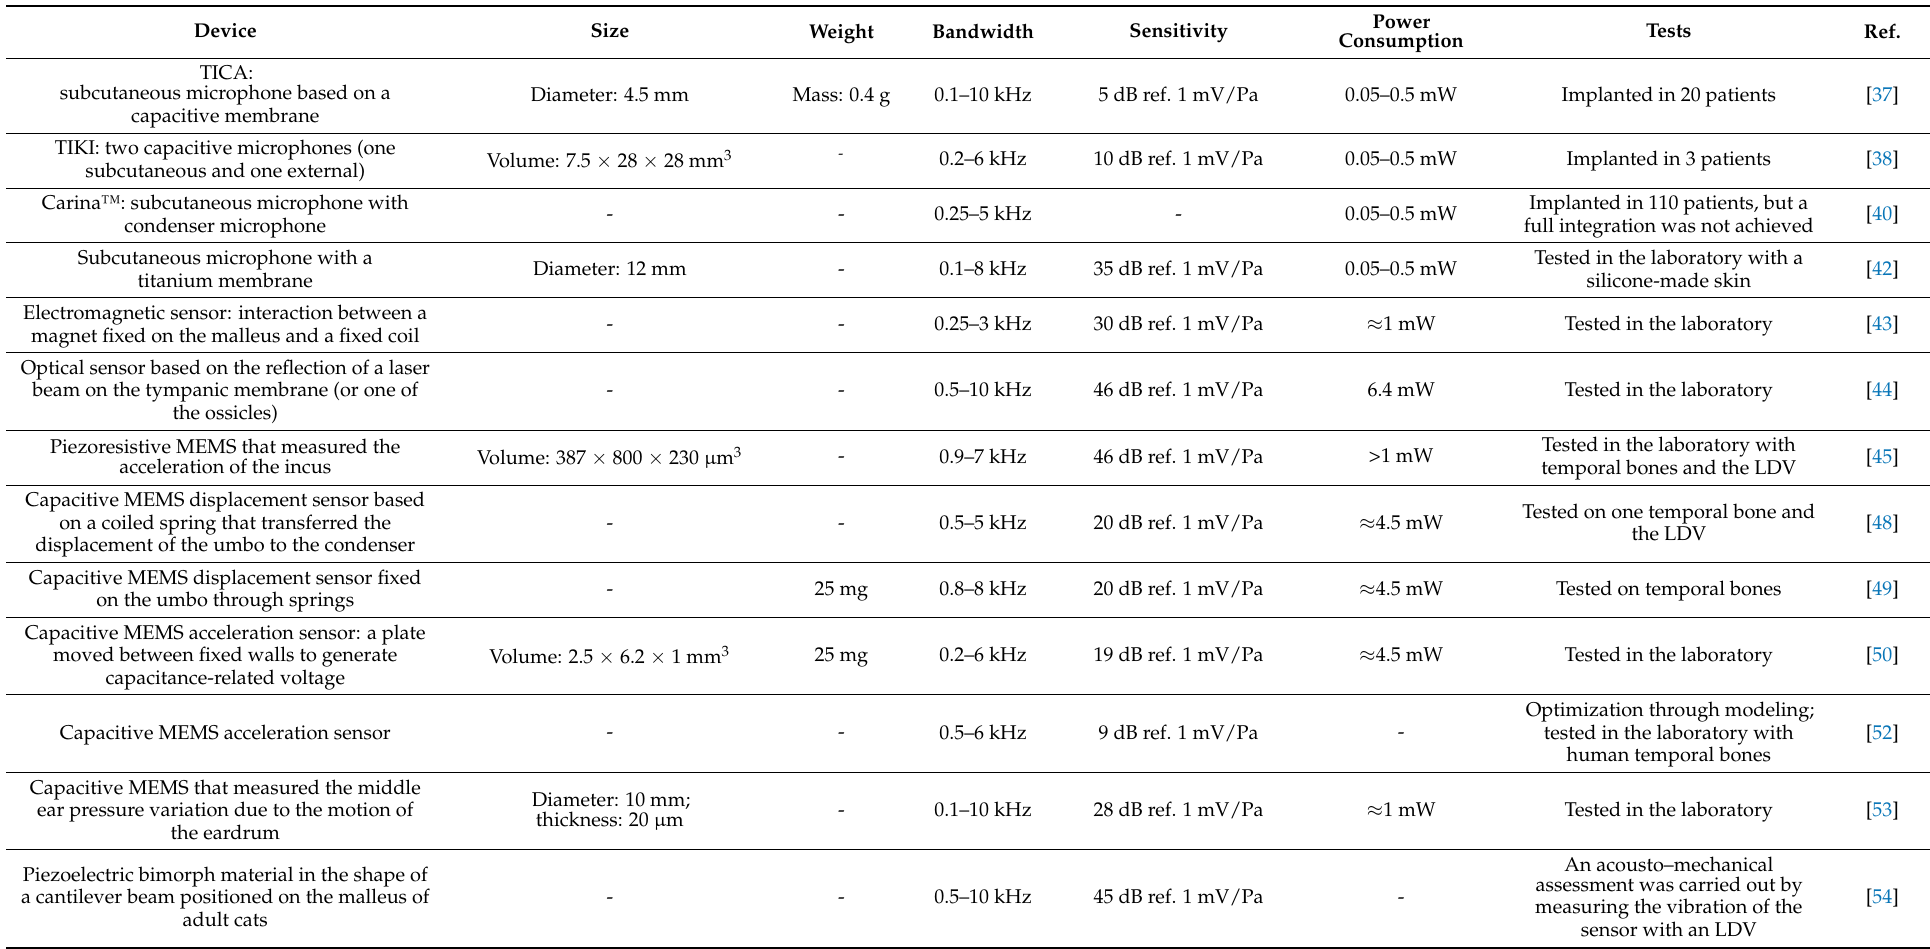
Table 1. Acoustic sensors for hearing